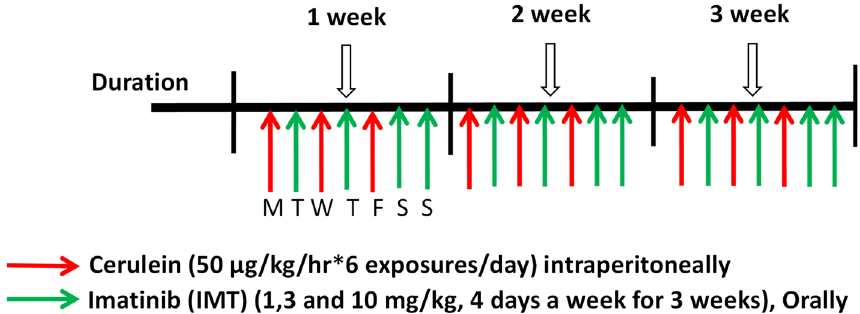
Figure 1. Experimental design for development and treatment of CP in mice. Male Swiss albino mice were randomly divided into 6 groups (7 mice per group): Normal control, IMT alone, Cerulein, Cerulein + IMT low dose (IMT LD—1 mg/kg), Cerulein + IMT mid dose (IMT MD—3 mg/kg) and Cerulein + IMT high dose (IMT HD—10 mg/kg). CP was induced by 6-hourly intraperitoneal (i.p.) injections of cerulein (50 μg/kg), 3 alternative days per week, for the period of 3 weeks. Cerulein + IMT group mice were administered IMT (1, 3 and 10 mg/kg) orally, every other day after cerulein exposures for 3 weeks. Normal control group mice received normal saline same as cerulein group. IMT alone group mice were administrated with IMT (10 mg/kg) orally 4 alterative days in the week for 3